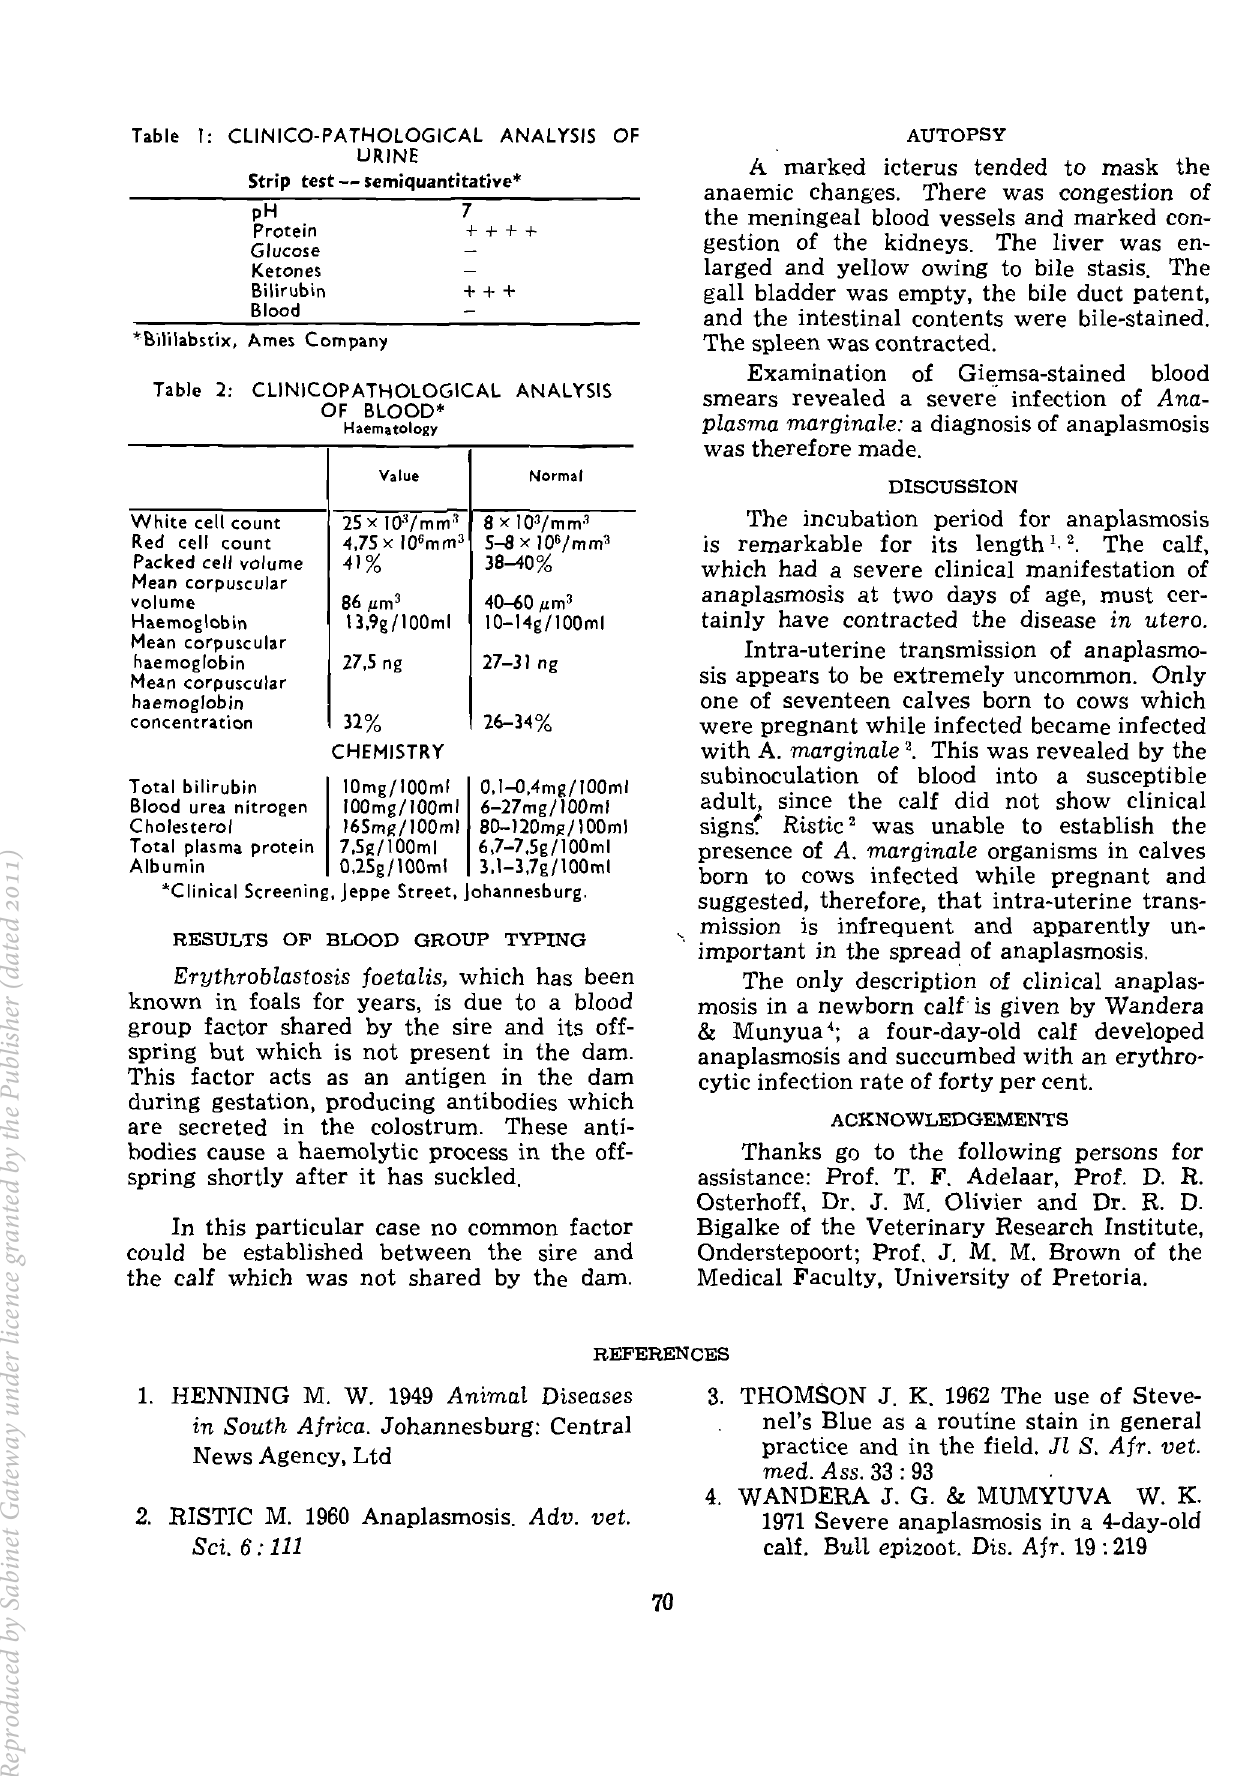
Table 2: CLINICOPATHOLOGICAL ANALYSIS OF BLOOD" Haem.tology Value